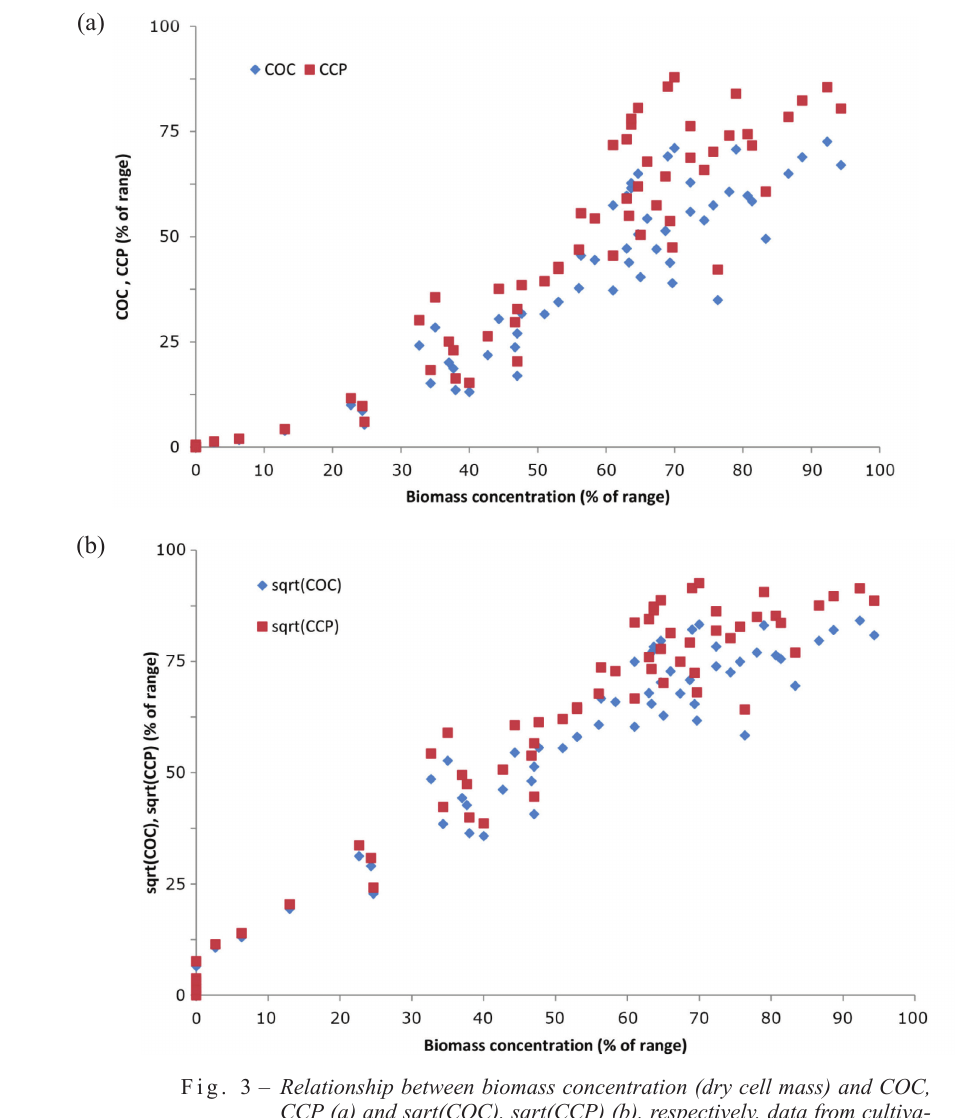
Fig. 3 – Relationship between biomass concentration (dry cell mass) and COC, CCP (a) and sqrt(COC), sqrt(CCP) (b), respectively, data from cultiva-